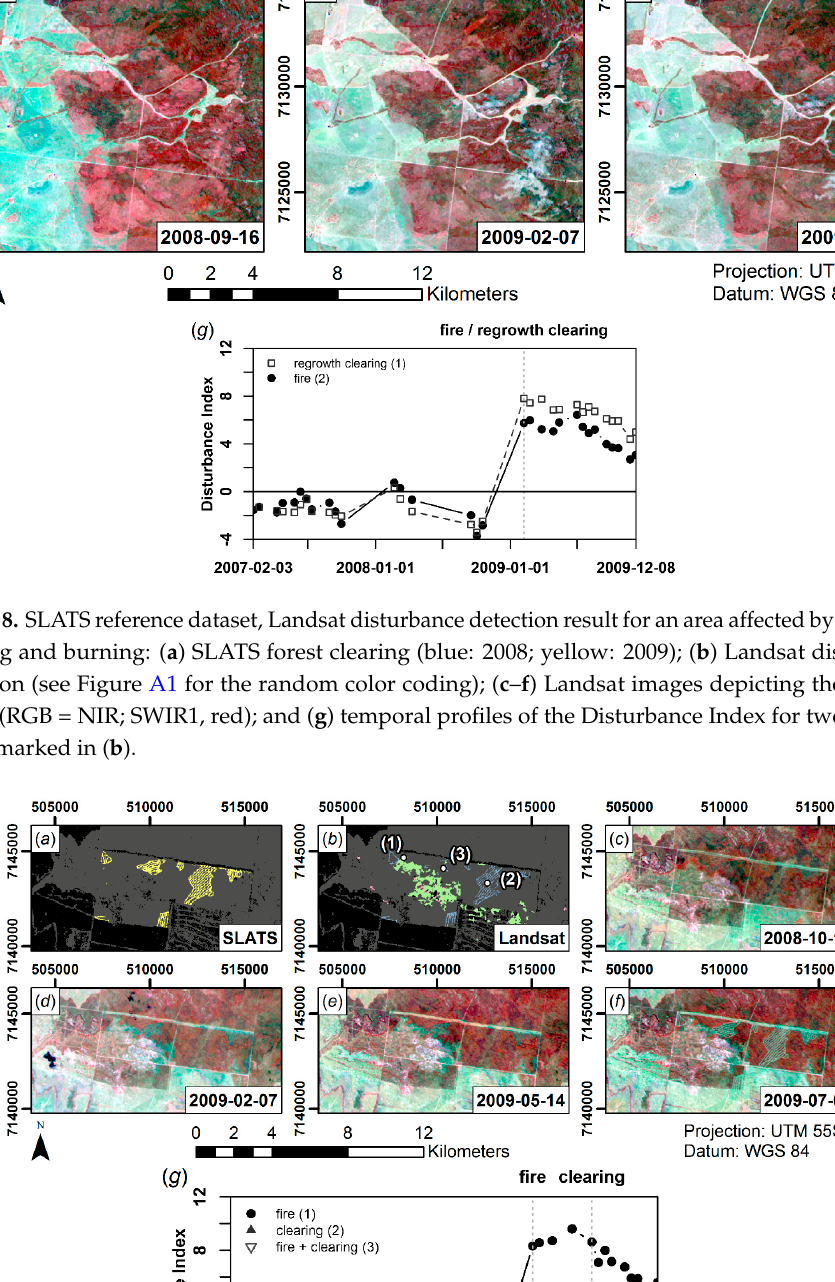
Figure 9. SLATS reference dataset, Landsat disturbance detection result for an area affected by clearing and burning: ( a ) SLATS forest clearing (blue: 2008; yellow: 2009); ( b ) Landsat disturbance detection (see Figure A1 for the random color coding); ( c – f ) Landsat images depicting the clearing stages (RGB = NIR; SWIR1, red); and ( g ) temporal profiles of the Disturbance Index for three selected pixels marked in ( b ).